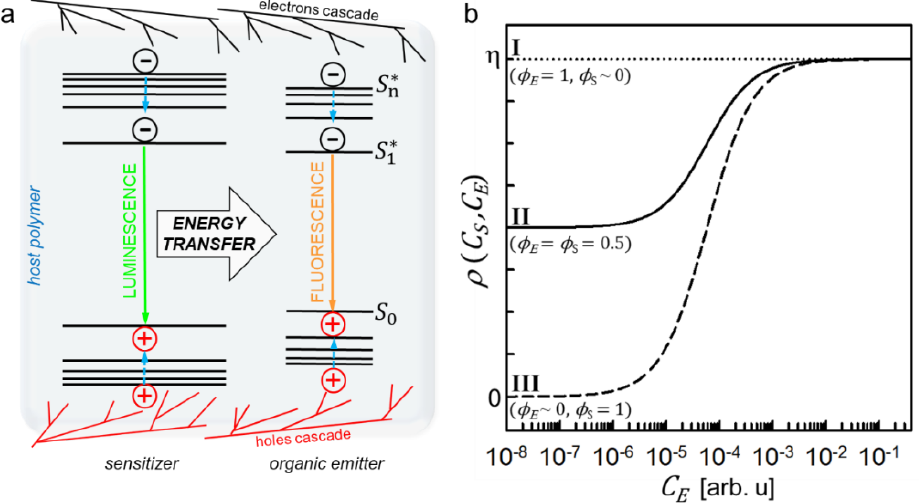
Figure 1. ( a ) Outline of the photophysics involved in the active sensitization of the scintillation process in composite materials based on organic emitters. The dye singlet ground state is indicated by S 0 . Excited dye singlet states are marked with *. Free charges are generated by interaction of the ionizing radiation with the polymer, sensitizer, and emitter moieties. They can recombine directly on emitters or on luminescent sensitizers. The resonance between the X-ray-activated luminescence of sensitizers and emitter absorption enables the sensitization of the emitter luminescence by radiative and non-radiative energy transfer from excited sensitizers. The fluorescent emitters generate the light pulse that will be detected by a photon counter. ( b ) Relative sensitization yield ρ calculated as a function of the energy transfer efficiency ( φ ET ) between the sensitizer and emitters in the case of dominant charge recombination on emitters (I), competitive recombination on sensitizers and emitters (II) and dominant recombination on sensitizers (III). The parameter 𝜂 is the relative increment of the energy deposition in the composite by charges ionization with respect to the unsensitized system.